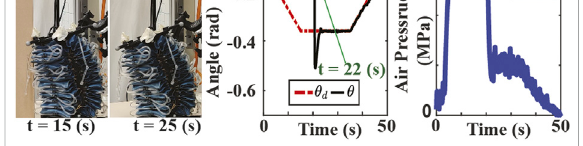
FIGURE 6 Experiment results of SMC approach tracking bending angle with stiff obstacle where the obstacle is removed permanently at 22 s. (A) The screen shots of the experiment video. (B) Bending angle tracking results where θ and θ d are the measured (solid black), and the original desired (dash-dotted red) bending angles, respectively. (C) Air pressure measurements of chamber